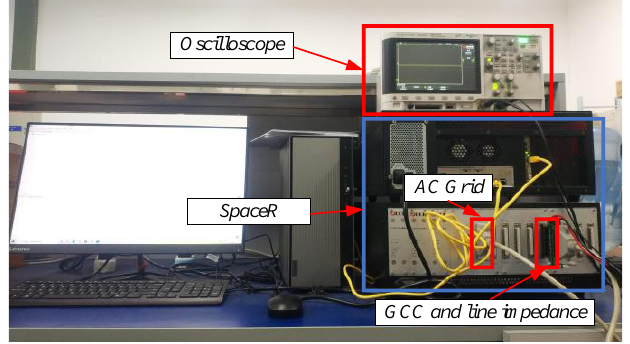
Figure 11. Experimental platform.